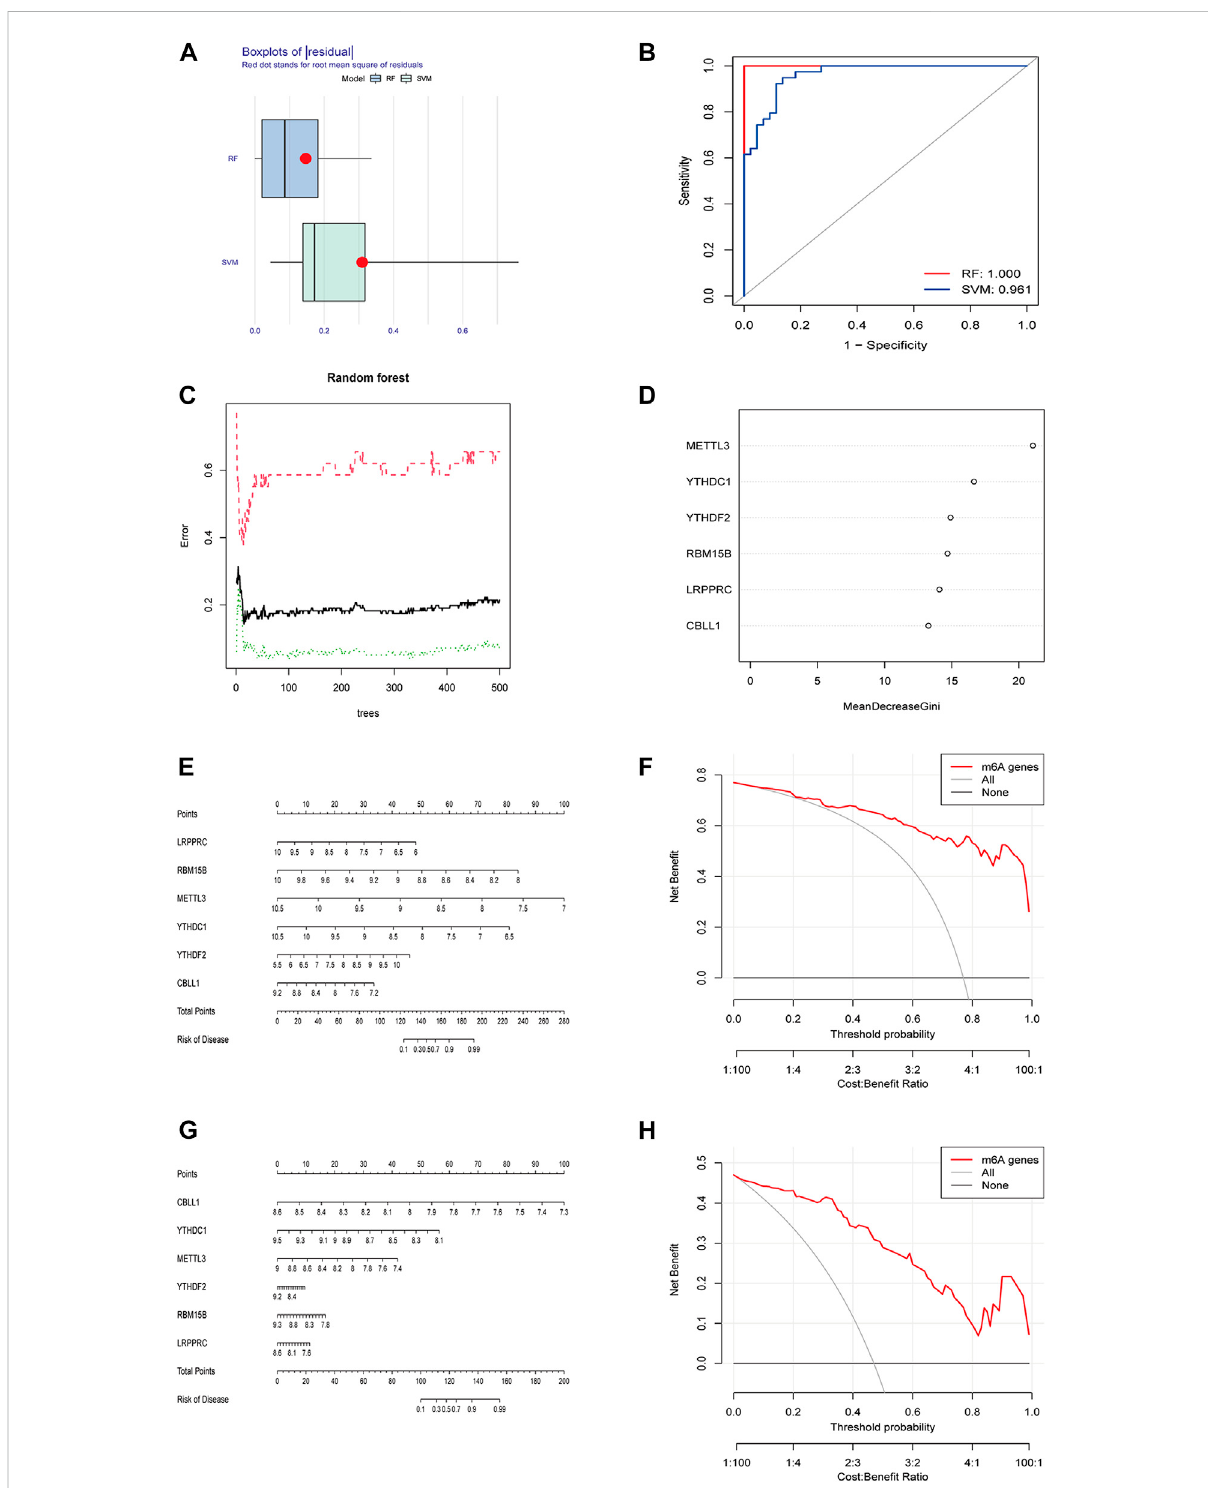
FIGURE 2 Building and validating of diagnostic models based on RFand SVMmachine learning methods. (A) Boxplot of residuals. (B) ROC curves for both models. (C) Construction of random forest model. (D) MDG value of 6 signi fi cant m6A-related DEGs. (E) Nomogram of the model based on the GSE16129 dataset. (F) Calibration curve of the text model. (G) Nomogram of the model based on the GSE30119 dataset. (H) Calibration curve of the validation model. RF, random forest; SVM, support vector machine; ROC, receiver operating characteristic; MDG, Mean Decrease Gini; DCA, Decision Curve